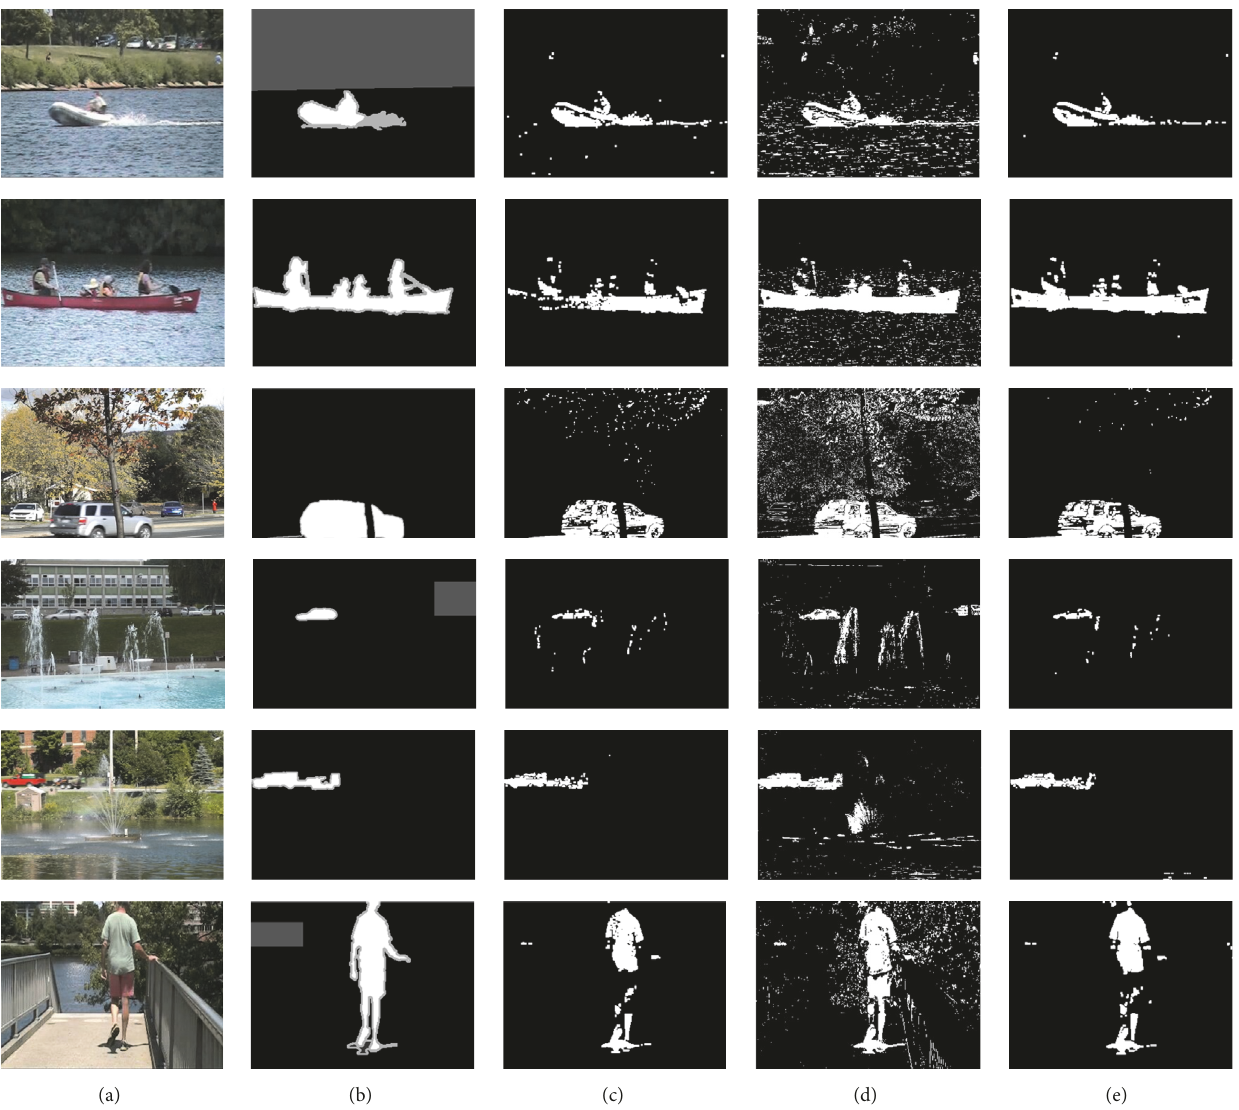
Figure 7: Comparison of the detection results. (a) Input frames of the six videos of “dynamic background” in changedetection.net, and they are the 2000th frame in “Boats,” the 955th frame in Canoe, the 1892th frame in Fall, the 1147th frame in “Fountain01,” the 745th frame in “Fountain02,” and the 2462th frame in “Overpass” from top to bottom. (b) Ground truth of (a). (c) Results of ViBe. (d) Results of CodeBook. (e) Results of the proposed method.